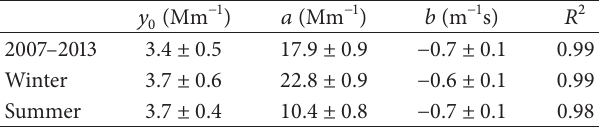
Table 2: Parameters ( ± standard errors) of the exponential fitting ( 𝑦 = 𝑦 0 + 𝑎 ∗ exp( 𝑏𝑥 )) between the wind speed and the absorption coefficient for 2007–2013 and for winter and summer